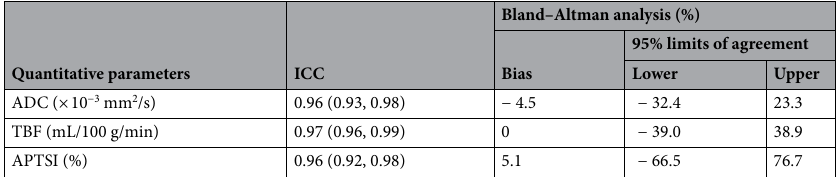
Table 1. Interobserver agreement. Numbers in parentheses are 95% confidence intervals. ADC, apparent diffusion coefficient; TBF, tumor blood flow; APTSI, amide proton transfer related signal intensity.